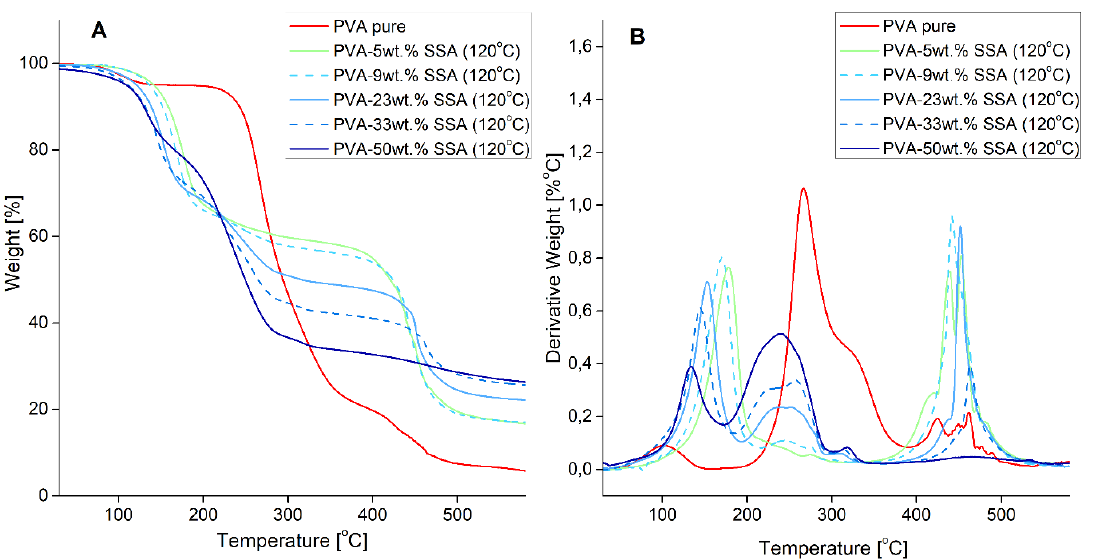
Figure 3. Thermogravimetric analysis of the heat-treated at 120 °C PVA-based membranes containing 5–50 wt.% SSA: ( A ) thermogravimetric curves and ( B ) differential thermogravimetric curves.